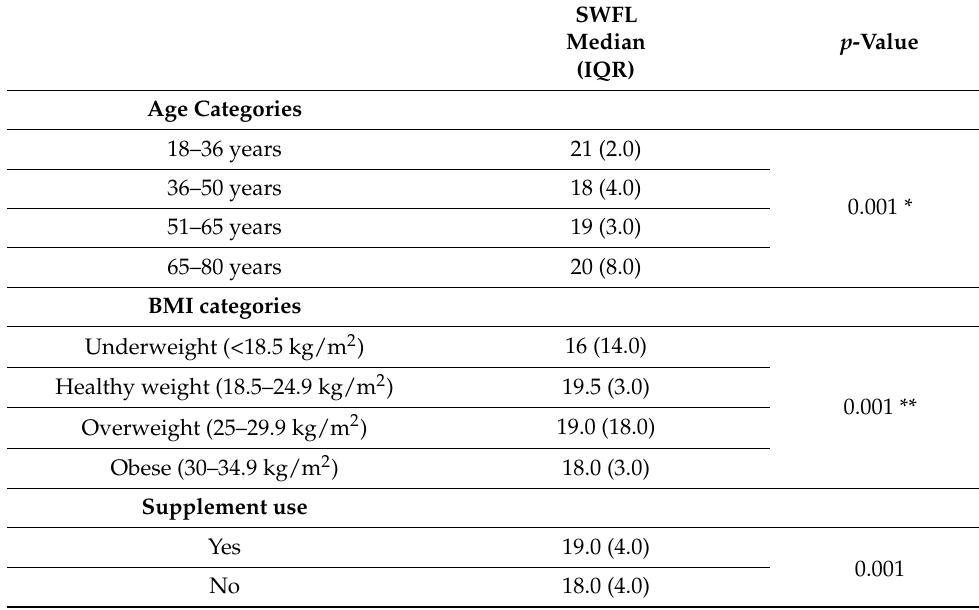
Table 4. Associations between the median (IQR) SWFL score and age category, BMI categories and supplement